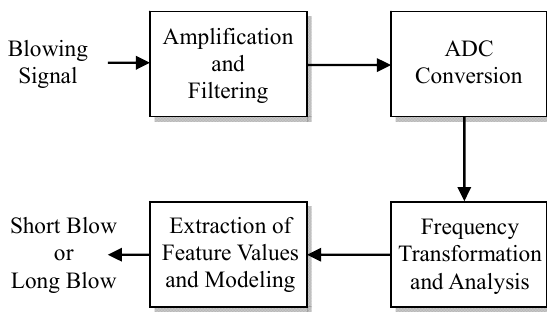
Figure 1. Conventional blowing signal processing.